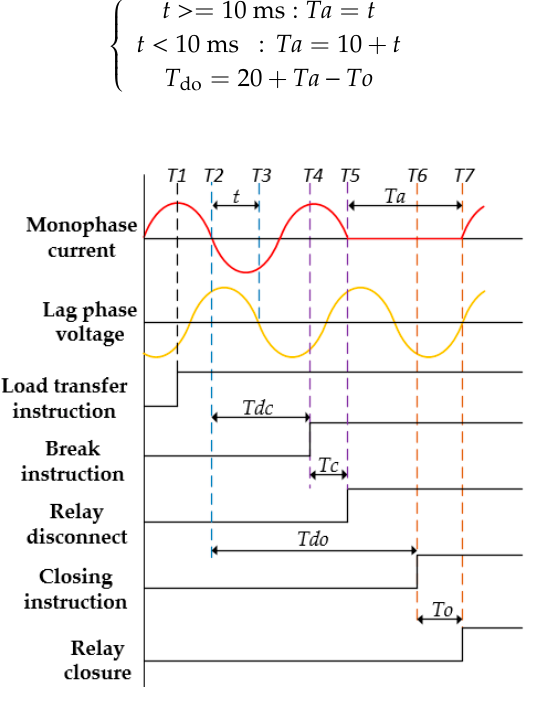
Figure 6. Sequence diagram of switch to lag phase.